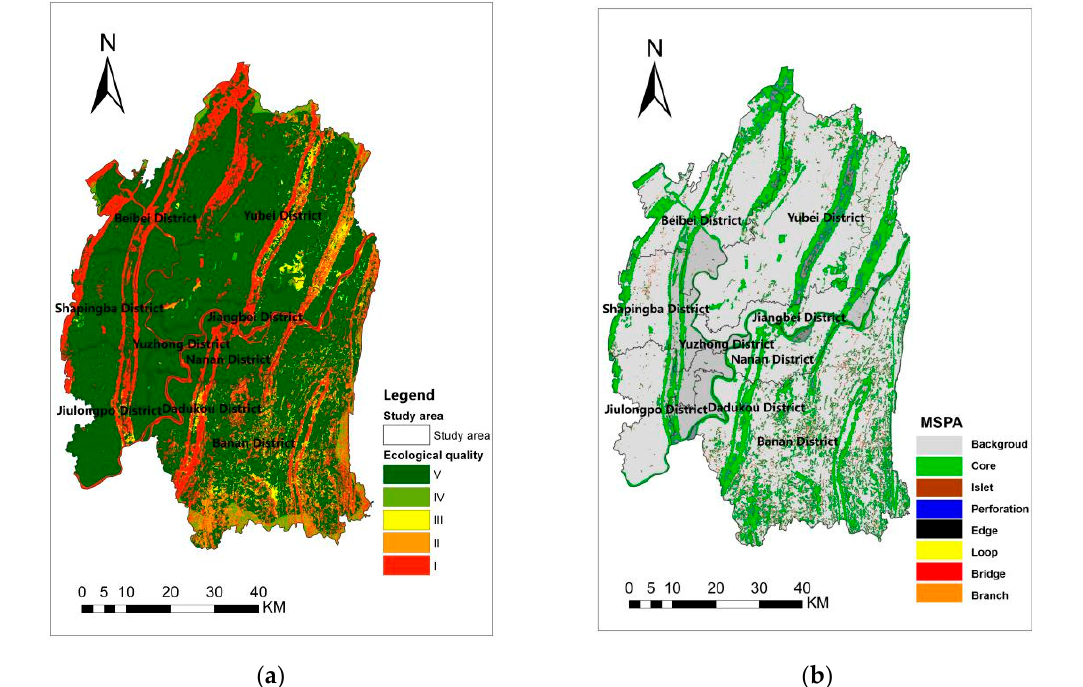
Figure 4. Ecological quality distribution and MSPA landscape pattern ( a ) Ecological quality distribution ( b ) MSPA landscape pattern.